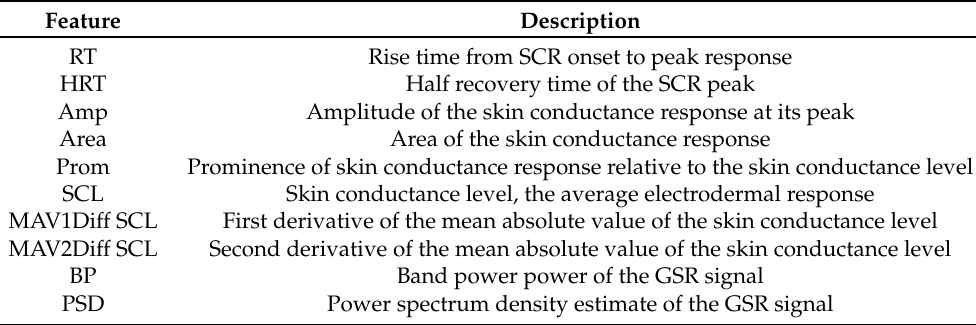
Table 2. Time and frequency domain GSR